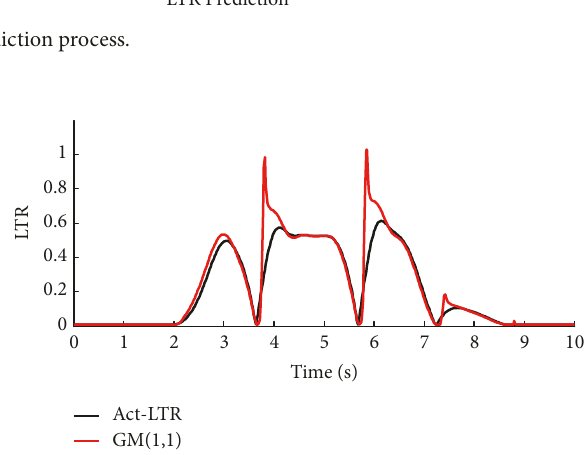
Figure 9: Prediction results in 85-km/h DLC using GM (1,1) .